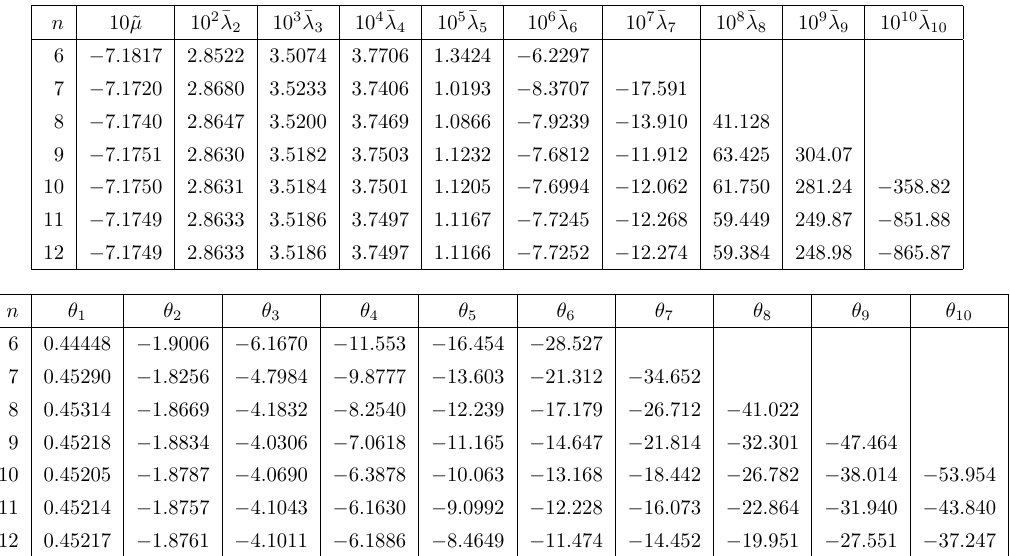
Table 2 . Values of the coupling constants and scaling exponents at the non-Gaussian fixed point in the large- N k regime for r = d r + 1 = 4 without η k in ( ¯ ϕϕ ) n truncation for ζ = 1 .